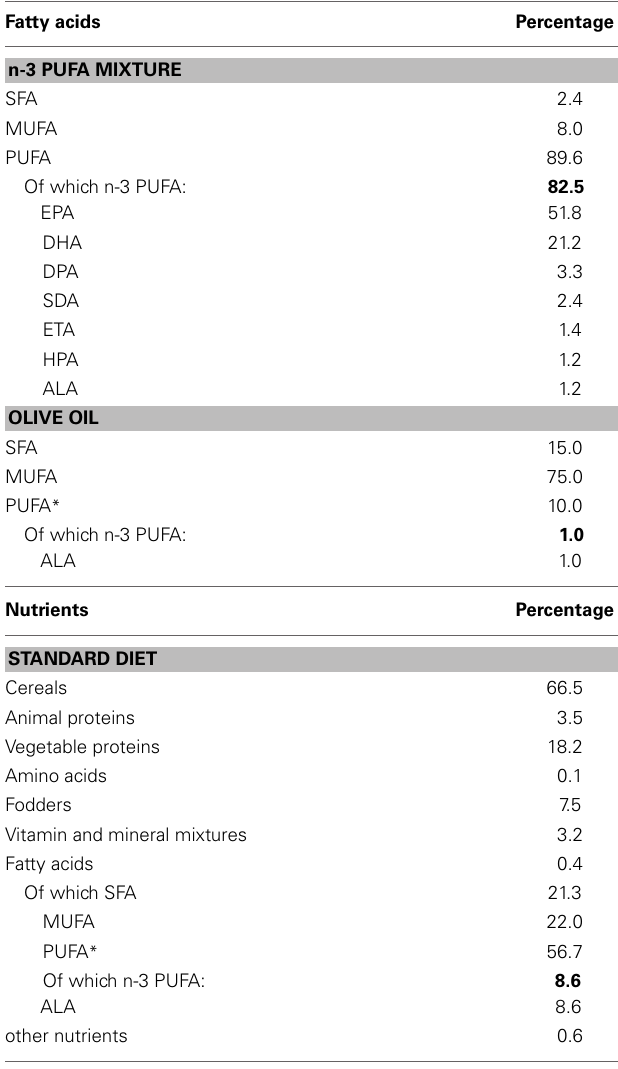
Table 1 | Fatty acid composition of the dietary supplements (n-3 PUFA, olive oil) and standard